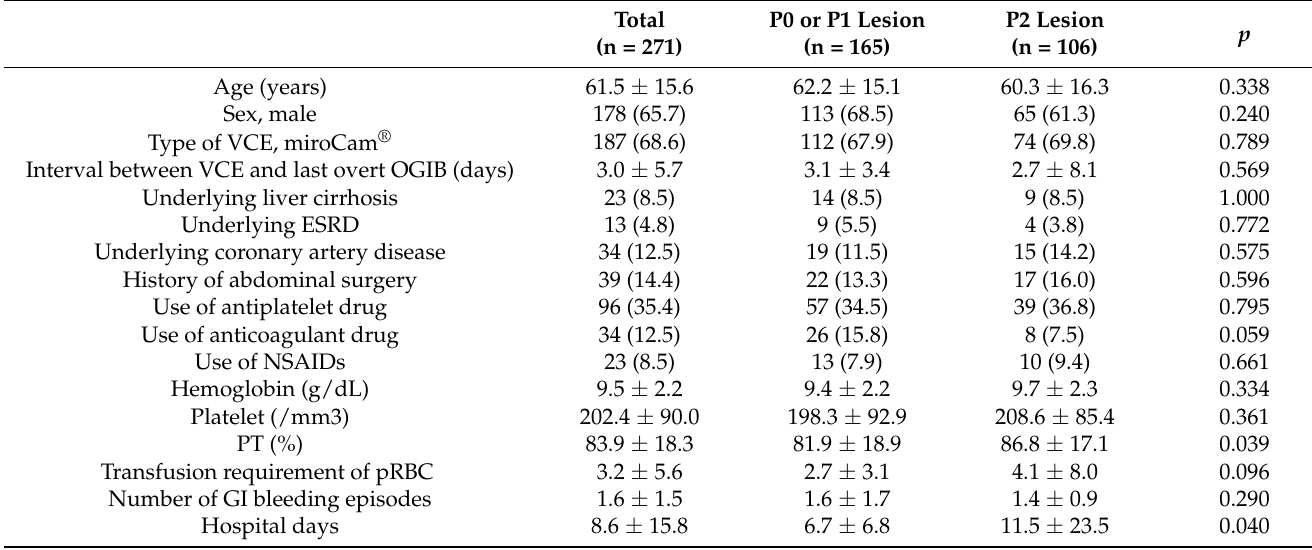
Table 1. Baseline characteristics of enrolled patients with P2 lesion and with P0 or P1 lesion on video capsule endoscopy finding.